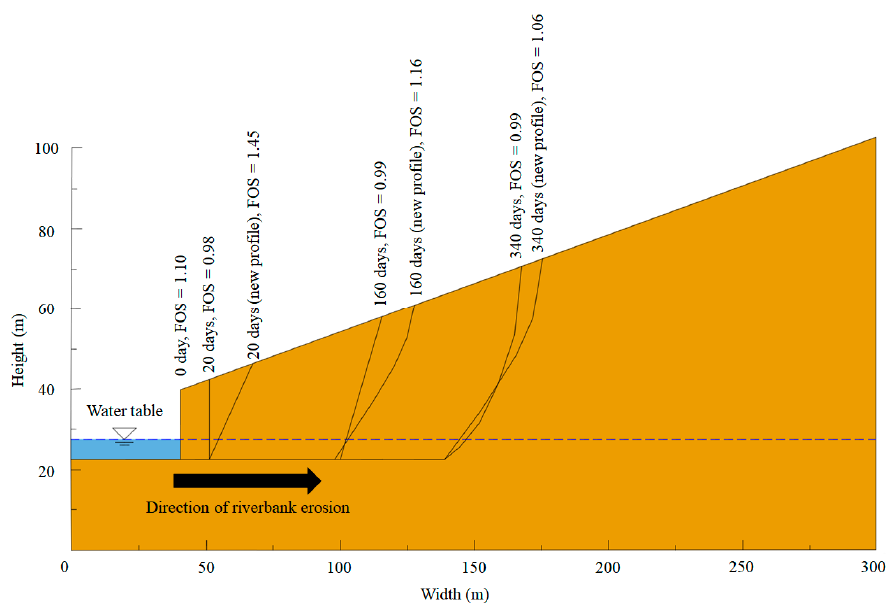
Figure 6. Evolution of the riverbank from 0 days to 340 days after the debris flow event on 4 September 2010.